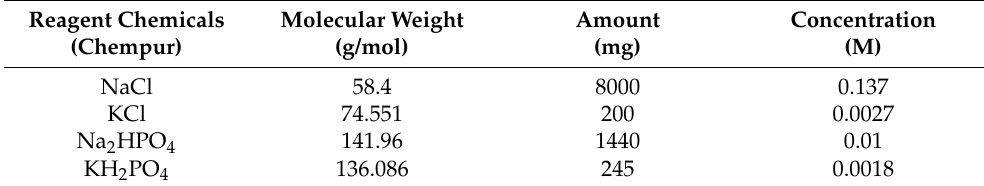
Table 3. The reagents used in the preparation of the 1 L buffer solution (PBS, pH 7.4). Reagent